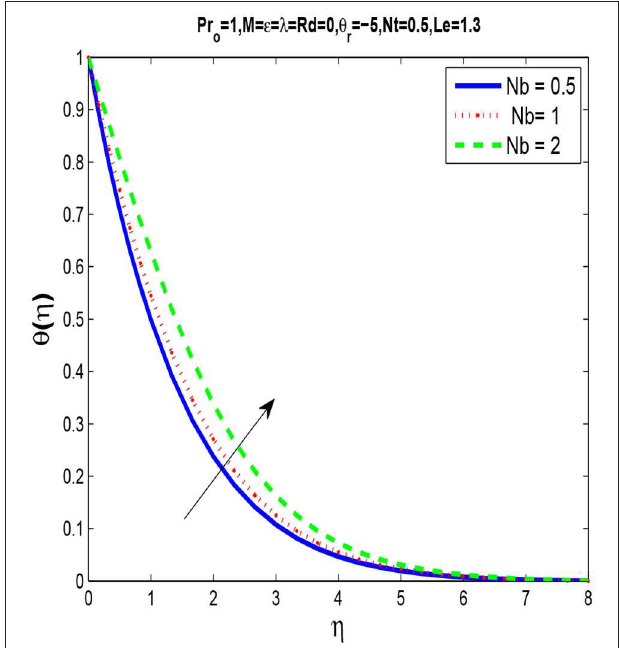
FIGURE 5 | Temperature profile θ ( η ) for different N b ( For Case B).